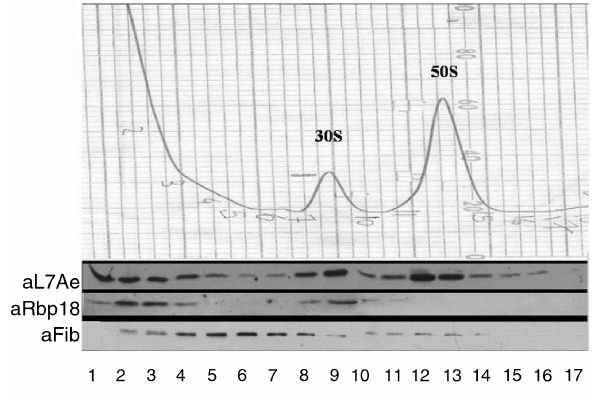
Figure 6. Localization of fibrillarin, Rbp18 and L7Ae. Sulfolo- bus solfataricus cell lysates were fractionated on sucrose density gra- dients; the fractions were checked for absorbance at 260 nm (top) to determine the position of the ribosomal subunits and for the presence of the different proteins using the specific antibodies against each of them as indicated (bottom). Abbreviations: aL7Ae, anti-L7Ae; aRbp18, anti-Rbp18; and aFib, anti-fibrillarin.